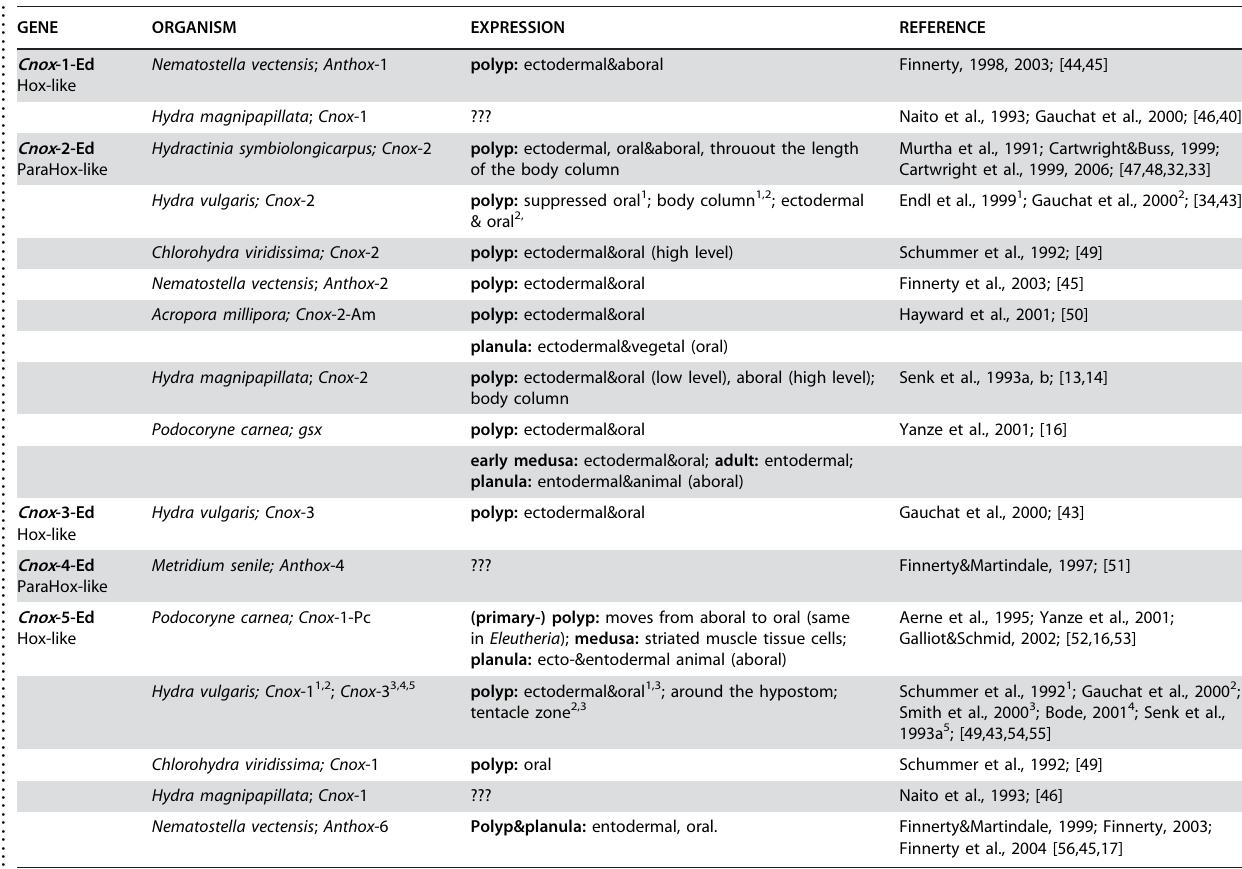
Table 2. Homology nomenclature and expression of Hox/ParaHox-like genes in Cnidaria. .. ... .... ... ... .... ... ... .... ... ... .... ... ... .... ... ... .... ... ... .... ... ... .... ... ... .... ... ... .... ... ... .... ... ... .... ... ... .... ... ... .... ... ...